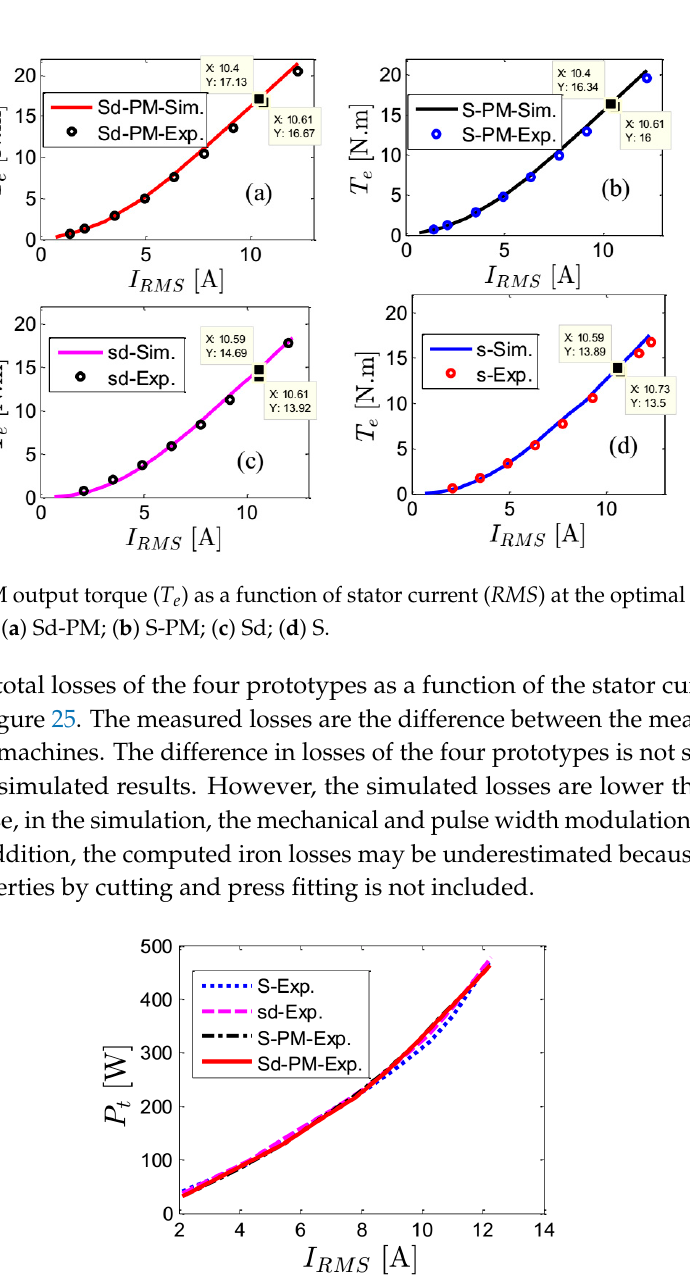
and rated speed. ( a ) Sd-PM; ( b ) S-PM; ( c ) Sd; ( d ) S.